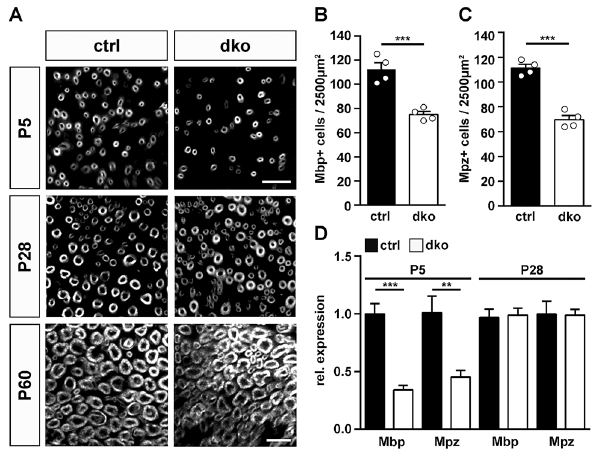
Figure 6. Myelin gene expression in sciatic nerves of dko mice. ( A ) Immunohistochemical detection of Mbp in sections of sciatic nerves of control and dko mice at P5, P28 and P60. Scale bar, 10 µm. ( B,C ) Quantification of Mbp- ( B ) and Mpz-positive ( C ) Schwann cells in the sciatic nerve of control (black bars) and dko (white bars) mice at P5 (n = 4; mean values ± SEM). ( D ) Quantification of the amount of Mbp and Mpz transcripts by qRT- PCR in sciatic nerves of control (black bars) and dko (white bars) mice at P5 and P28 (n = 6). Transcript levels in controls were set to 1 for each gene, those for dko mice expressed relative to it (± SEM). Statistical significance was determined by unpaired two-tailed Student’s t-test (**P ≤ 0.01; ***P ≤ 0.001). For p-, t- and df-values, see Supplementary Fig.